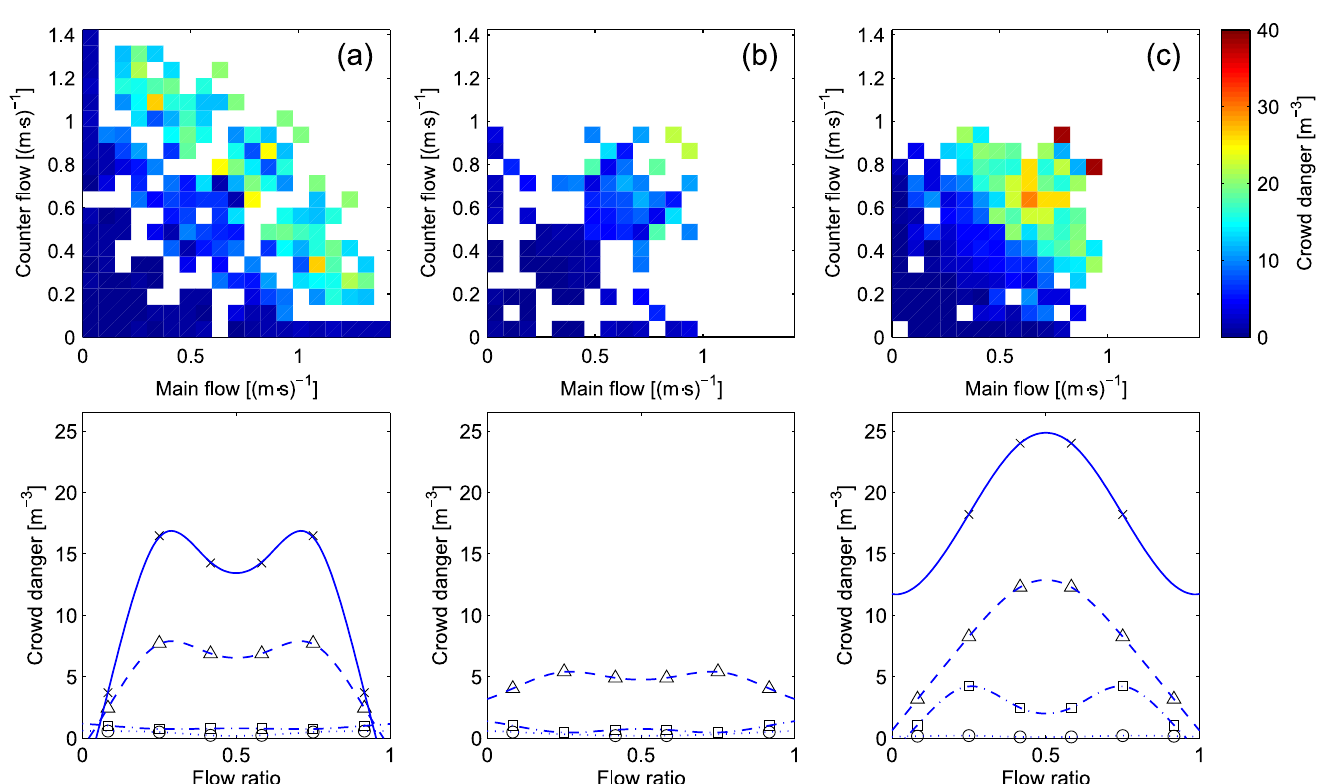
Fig 10. Crowd danger. The same color scale is used for all scatter plots. Interpretation for the flow ratio representation is provided in Table 4.